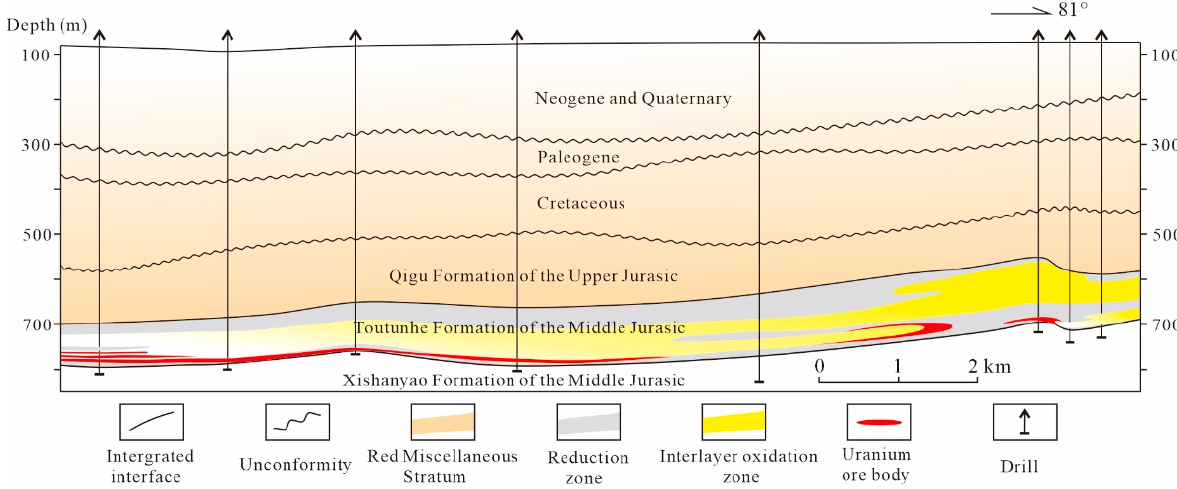
Figure 2. The spatial relationship between interlayer oxidation zone and uranium mineralization in the Kamust uranium deposit.